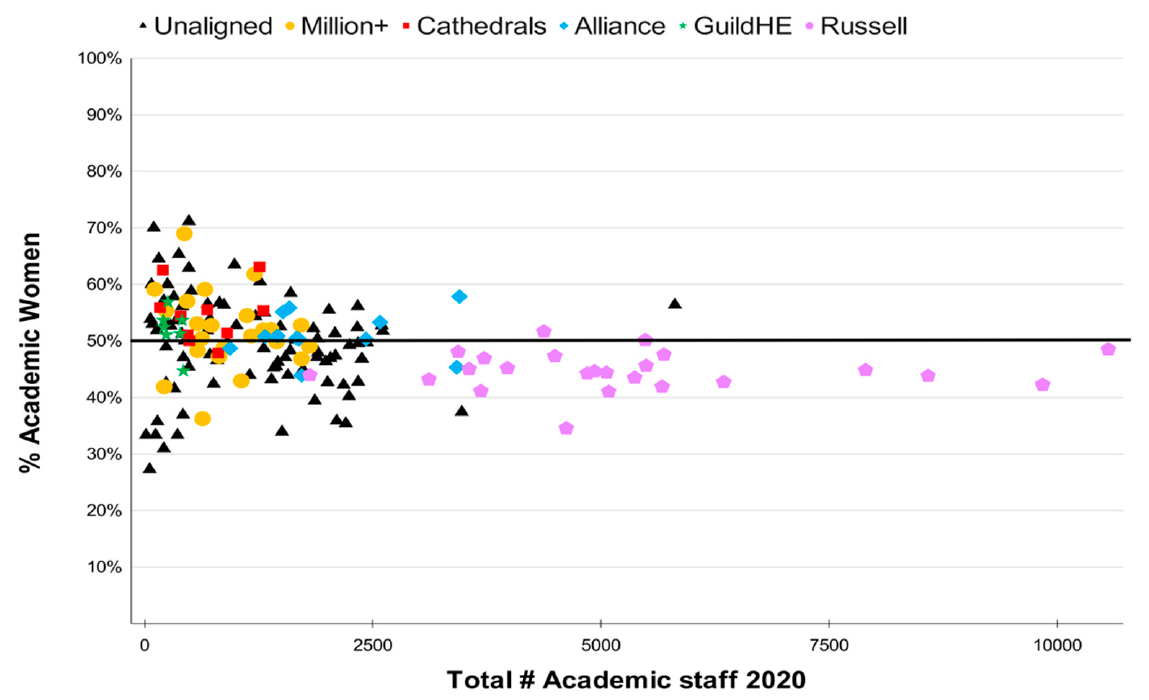
Figure 6. Percentages of women academic staff (headcount) compared to the total number of